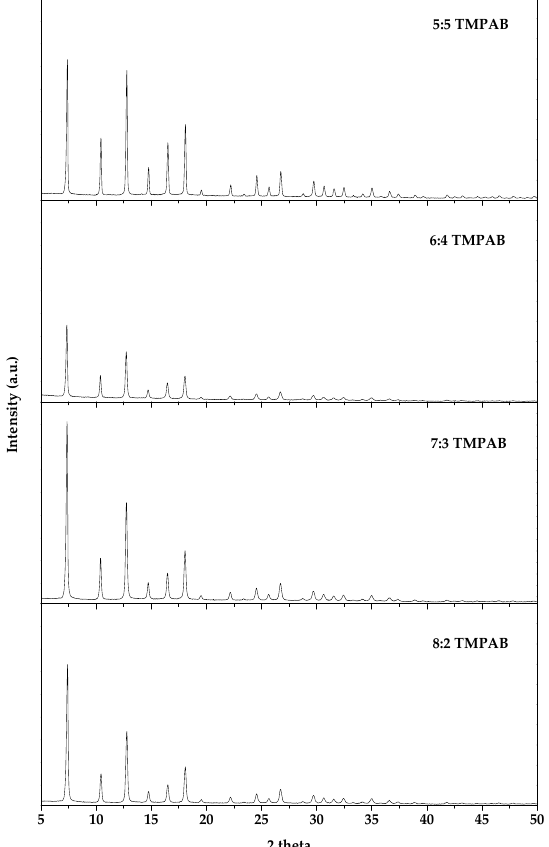
Figure 6. XRD patterns of synthesized ZIF-8 with TMPAB at a ratio between 2-MeIM and TMPAB as 5: 5, 6: 4, 7: 3 and 8: 2.